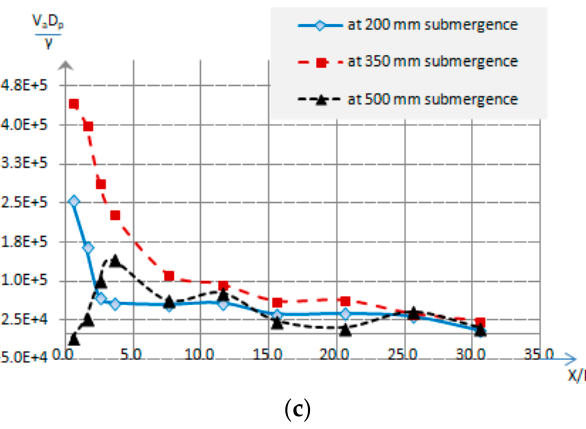
Figure 4. ( a ) Mean axial flow velocity along x/D p at y/D p = 0 and at d = 0.25D p for different ‘H’; ( b ) mean axial flow velocity along x/D p at y/D p = 0 and at d = 0.55D p for different ‘H’; ( c ) mean axial flow velocity along x/D p at y/D p = 0 and at d = 1.05D p for different ‘H’.